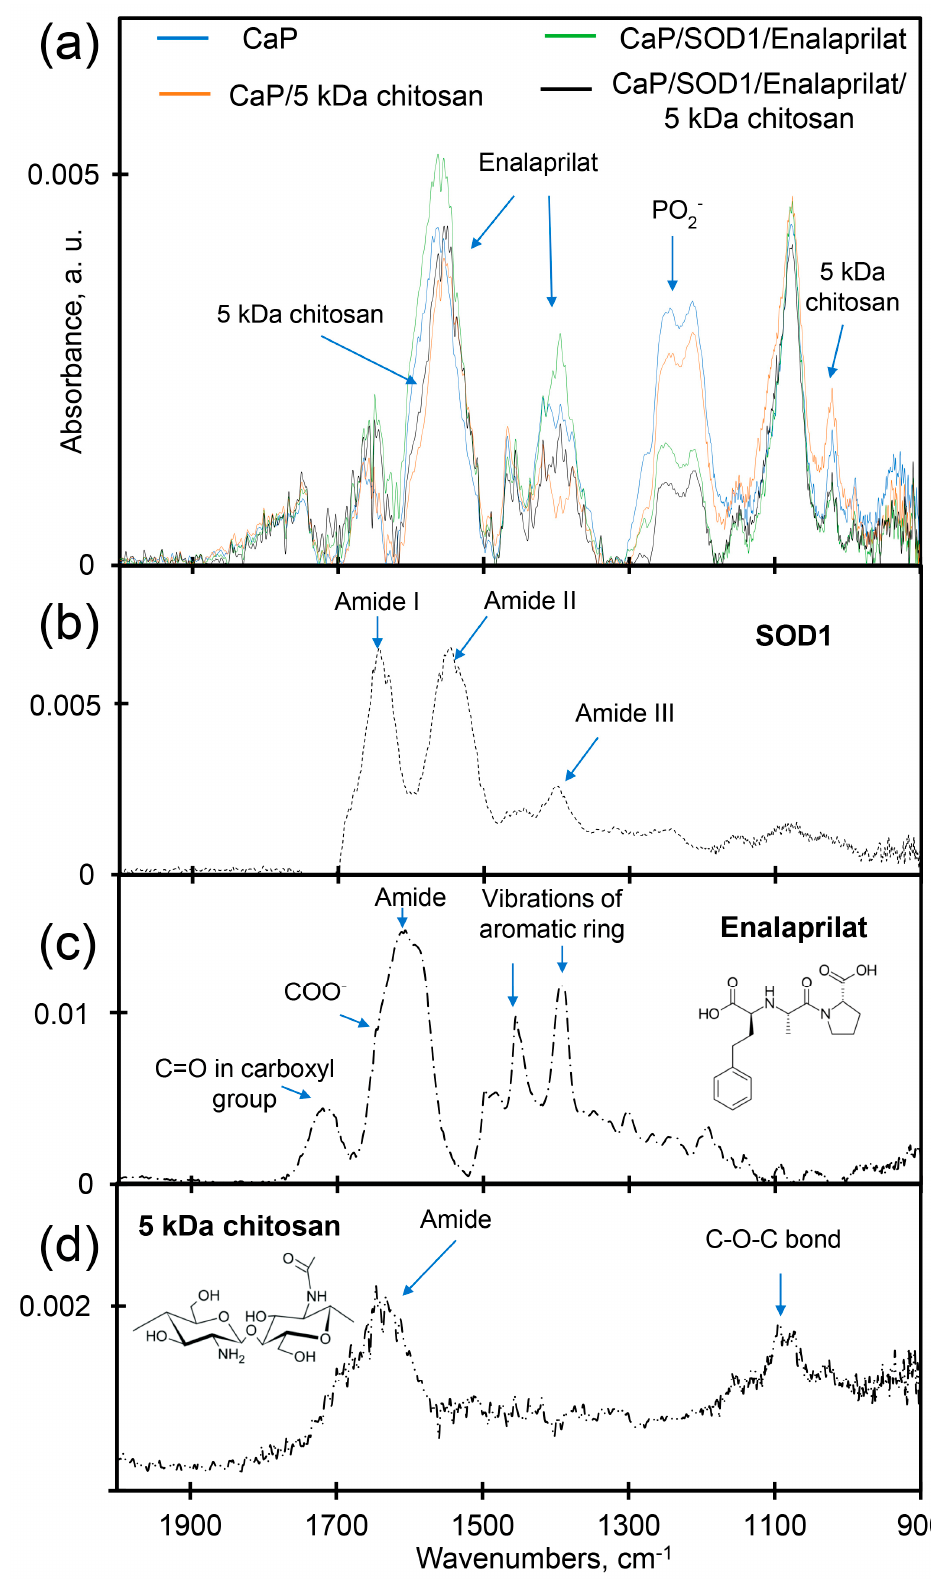
Figure 2. ATR-FTIR spectra of ( a ) CaP-particles (blue), empty hybrid particles (orange), SOD1/enalaprilat co-loaded CaP-particles (green), SOD1/enalaprilat co-loaded hybrid particles (black); ( b ) SOD1, ( c ) enalaprilat, ( d ) 5 kDa chitosan. The coating of empty CaP-particles and co-loaded SOD1/enalaprilat CaP-particles resulted in a decrease in intensity (quenching) in the 1600–1500 cm − 1 region and the shift of the band at 1620–1700 cm − 1 to low-frequency region due to the interaction of the parti-